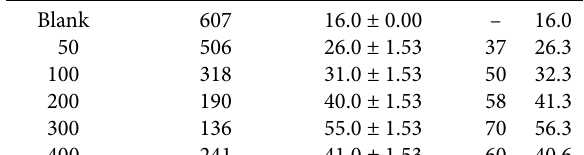
Figure 3. Equivalent circuit to estimate impedance